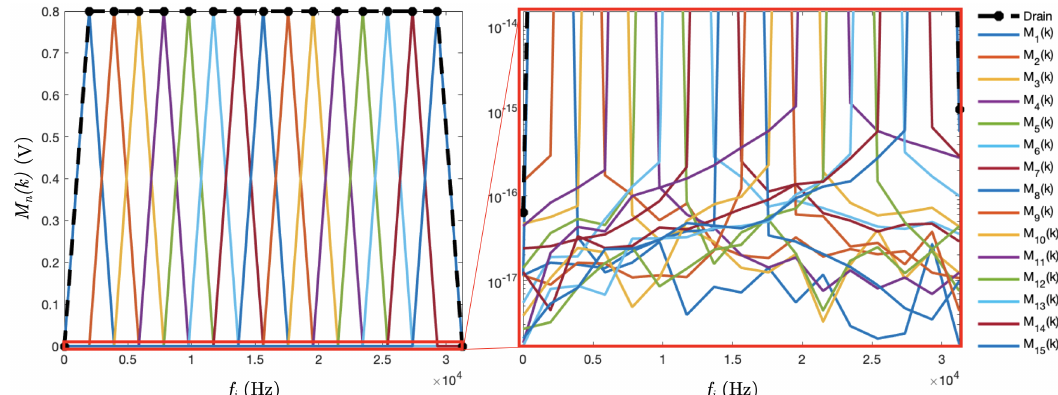
Figure 5. Simulation of the magnitudes of the 15 frequencies plus the drain at the 16 channels. On the right, rescaled zoom in the bottom part in the logarithmic scale of the DFT plot to show the tails of the peaks due to the discretisation onto 512